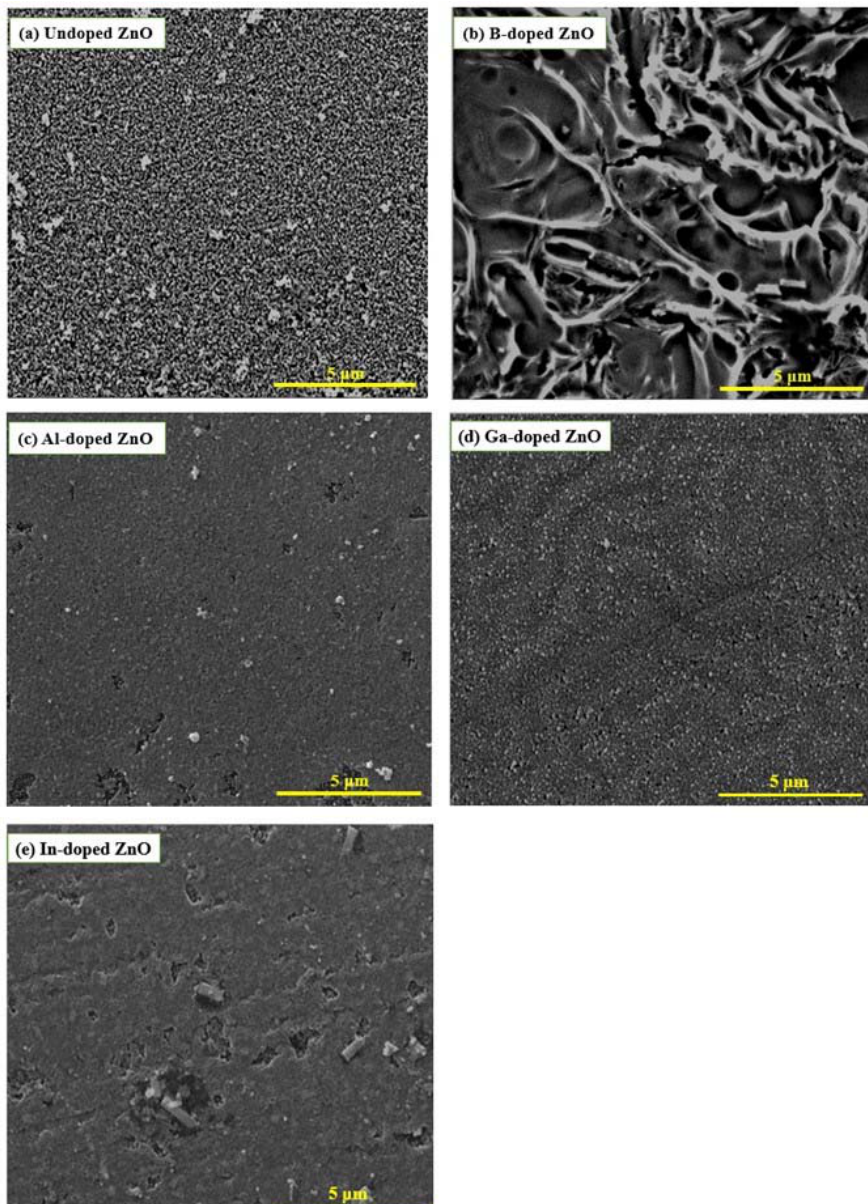
Figure 5. SEM micrographs of ( a ) undoped ZnO, ( b ) B-doped ZnO, ( c ) Al-doped ZnO, ( d ) Ga-doped ZnO, and ( e ) In-doped ZnO thin films.